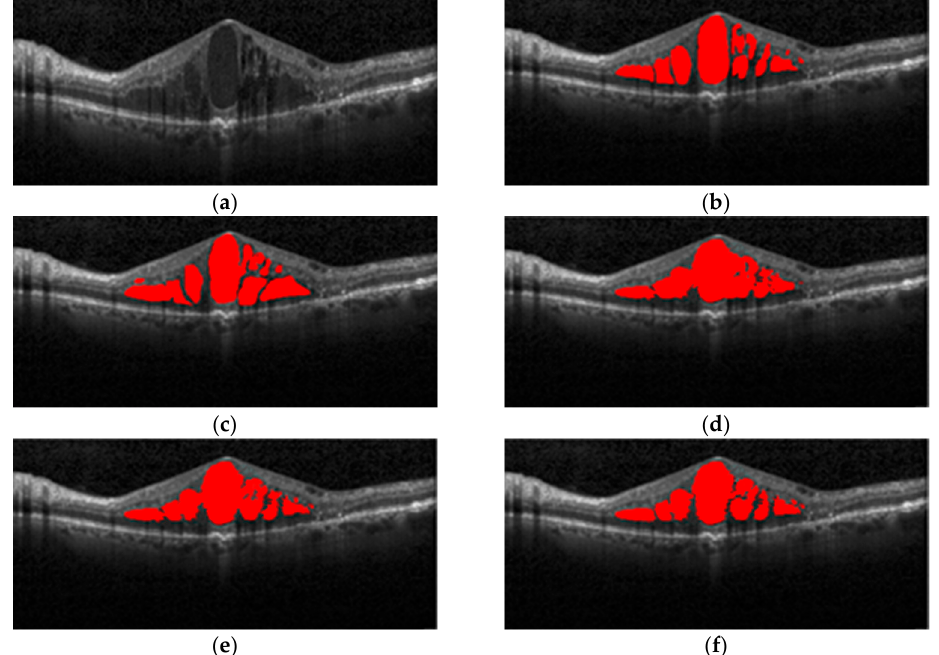
Figure 10. Segmentation effect of different models on the multi-scale and multi-region macular edema OCT image test set: ( a ) original image; ( b ) expert 1 annotations; ( c ) expert 2 annotations; ( d ) TransUNet predictions; ( e ) Res-UNet++ predictions; ( f ) the proposed method predictions.